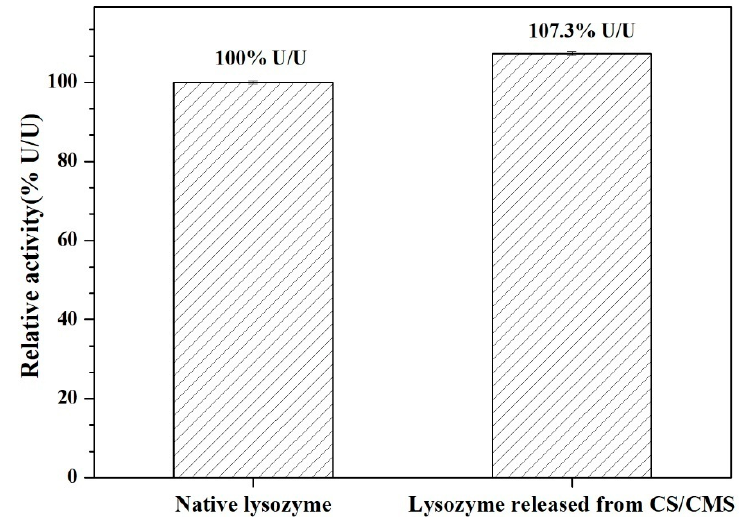
Figure 5. Relative activity of lysozyme released from CS/CMS. Bars represent the corresponding standard deviations ( n = 3).